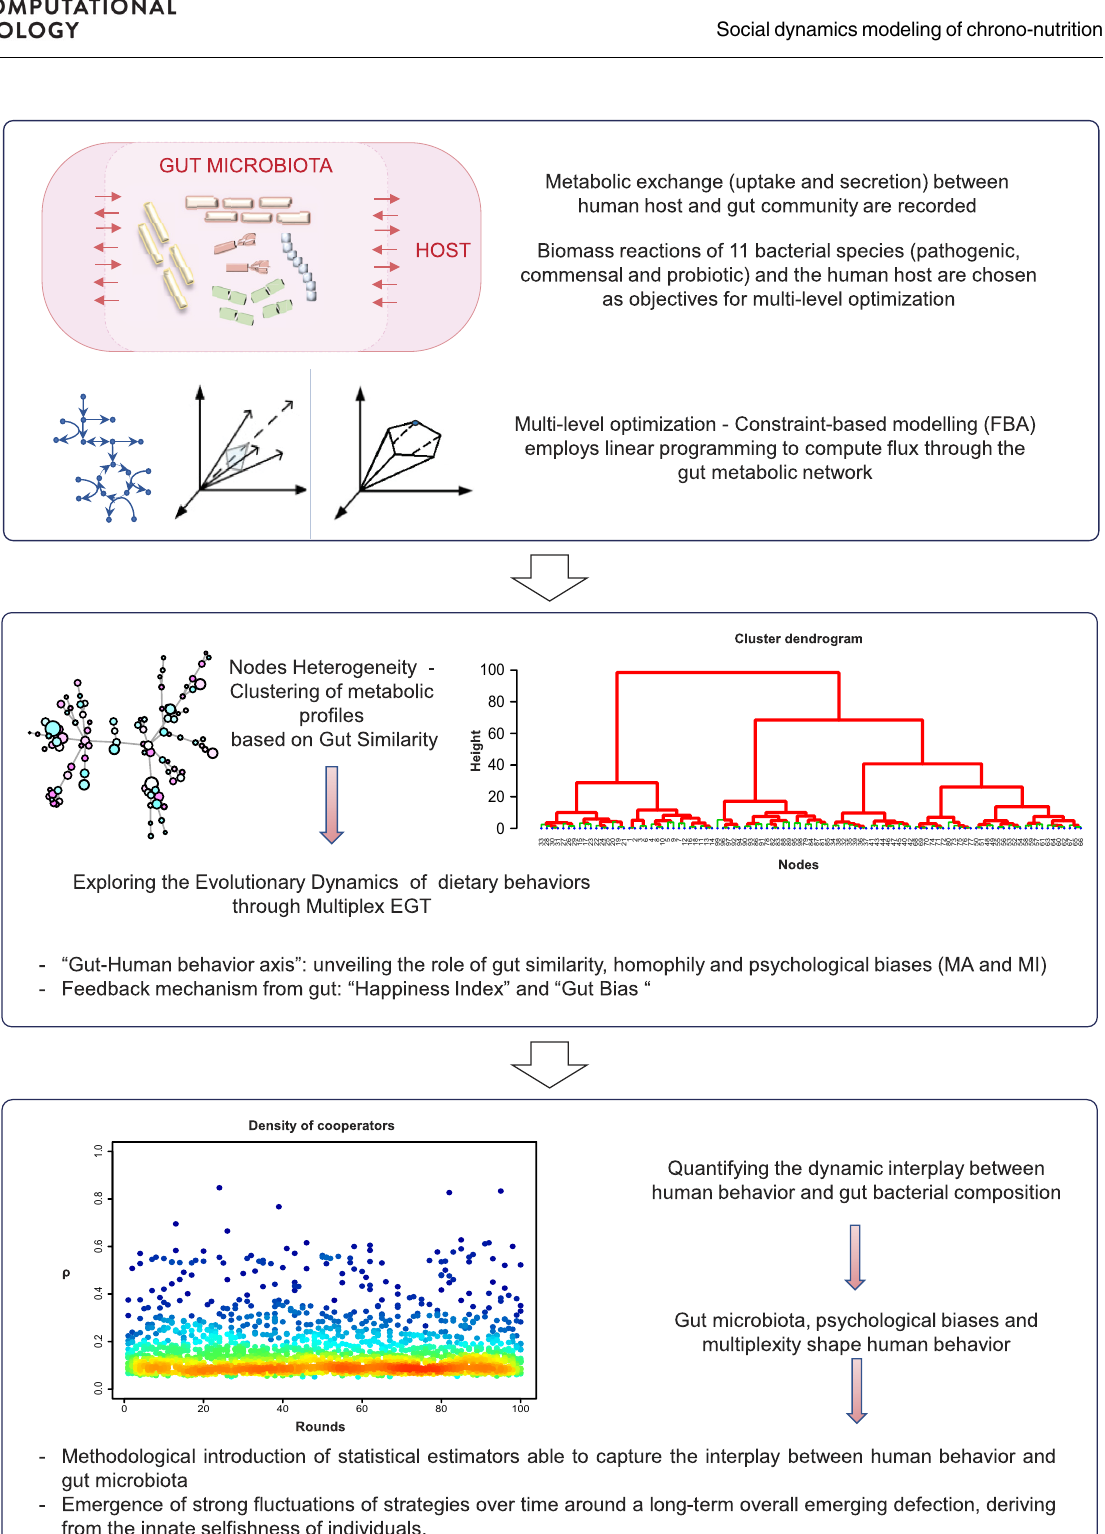
Fig 1. Modeling approach. Bio-molecular step (top panel); associations between humans and gut bacterial species, clustering based on gut similarity (middle panel); dynamic interplay between human behavior and gut microbiota (bottom